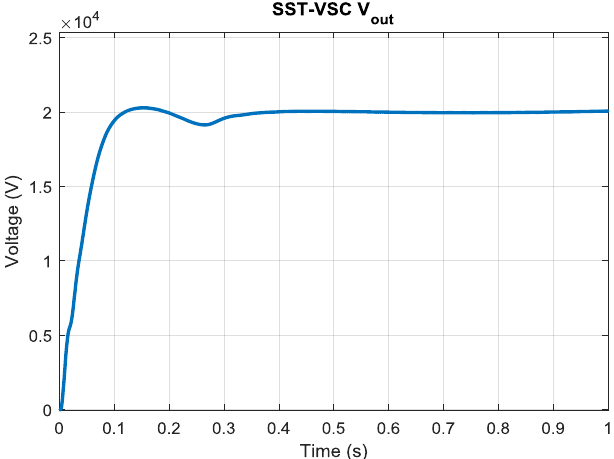
Figure 18. SST-VSC response with induction motor loading.